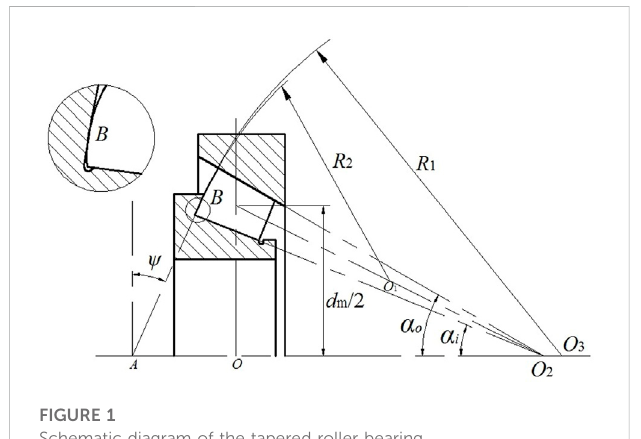
FIGURE 1 Schematic diagram of the tapered roller